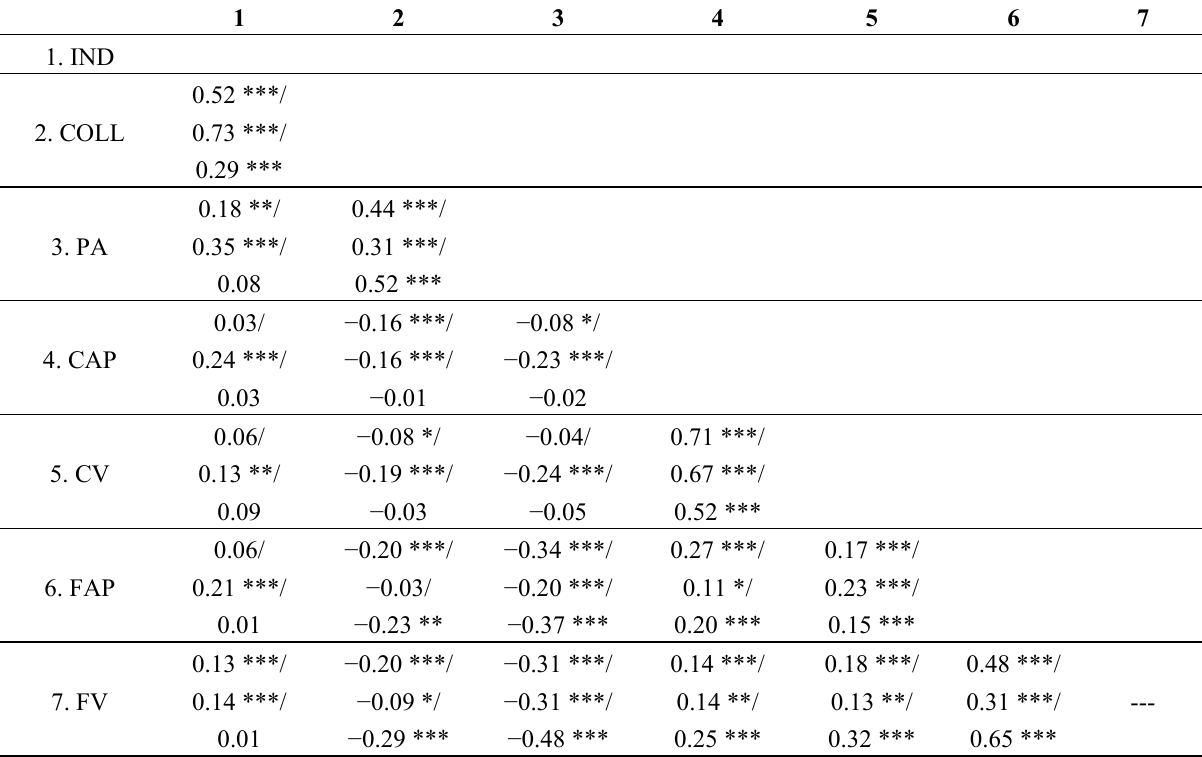
Table 1. Correlation among all variables for Chinese, Indian, and Japanese